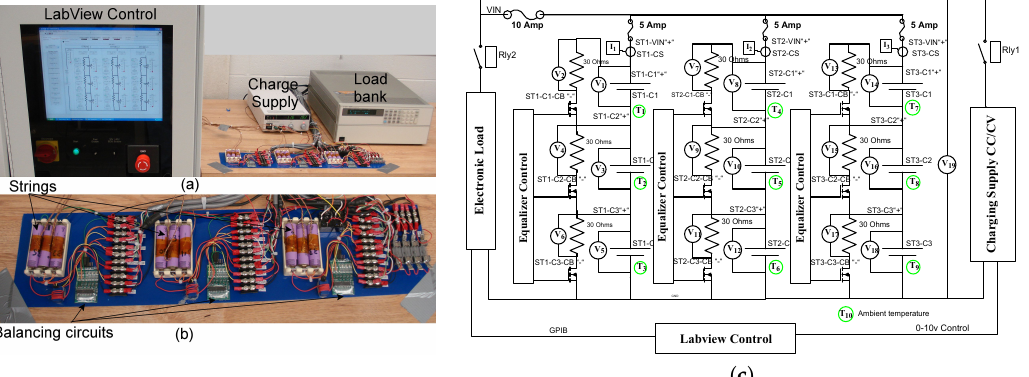
Figure 1. 3S3P pack ( a ) LabVIEW-controlled fixture; ( b ) enlarged view of the pack; ( c )